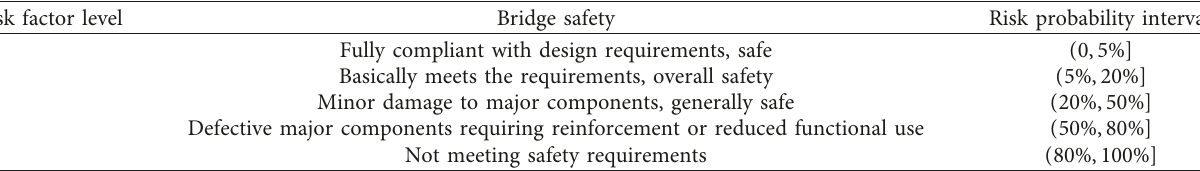
Table 2: Safety status classes of existing railway bridges.